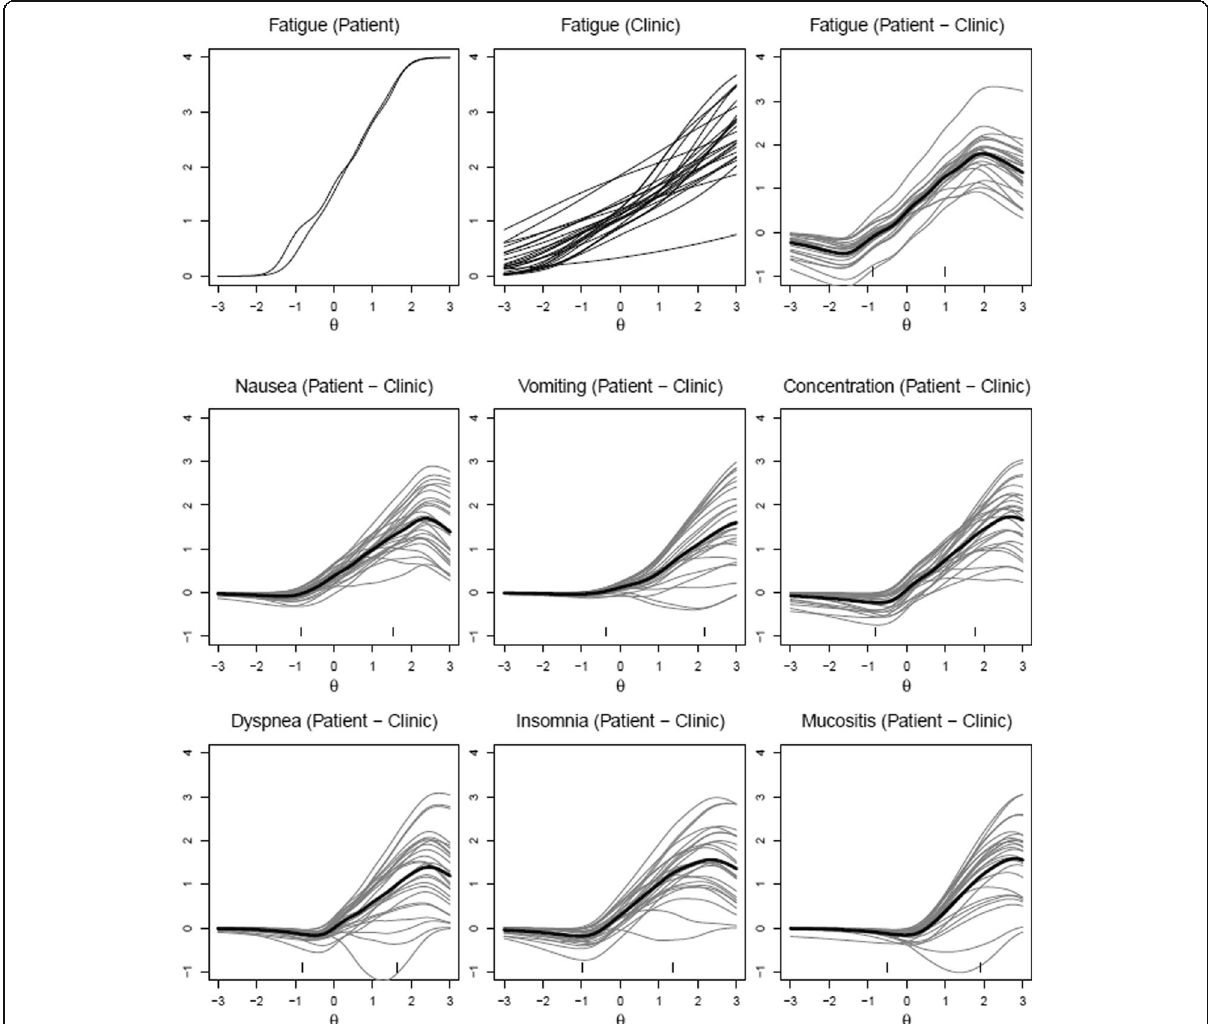
Fig. 2 Graded Response Model Estimates for Patients/Clinicians, and Difference between Patient and Clinicians for Two-Attribute Symptoms. Note: X-axis represents underlying distribution of AE in the population ( θ parameter in the GRM); Y-axis represents the model estimated AE ratings. In the case of fatigue, θ represents severity and interference with daily